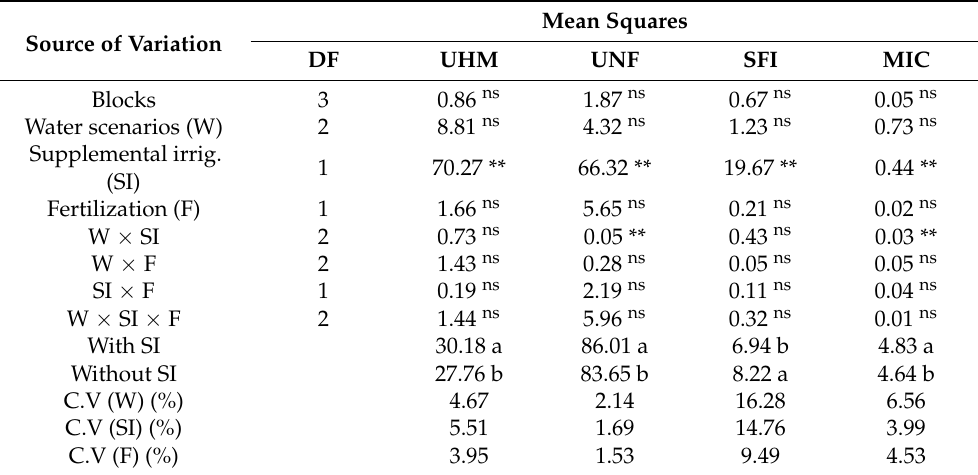
Table 5. Summary of analysis of variance for fiber length (UHM), fiber uniformity (UNF), short fiber index (SFI), and micronaire index (MIC) of cotton, as a function of water scenarios (W), supplemental irrigation with treated wastewater (SI), and chemical fertilization